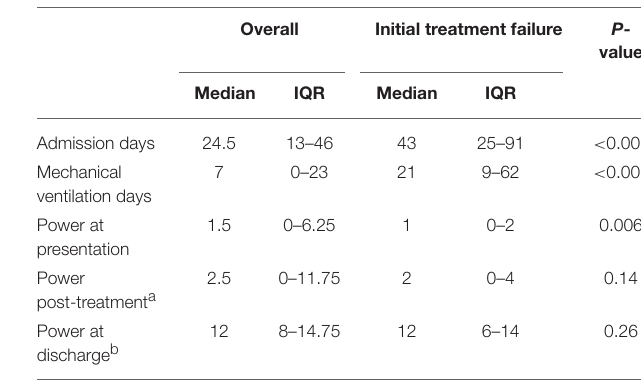
TABLE 3 | Duration of support and motor power progression in the study